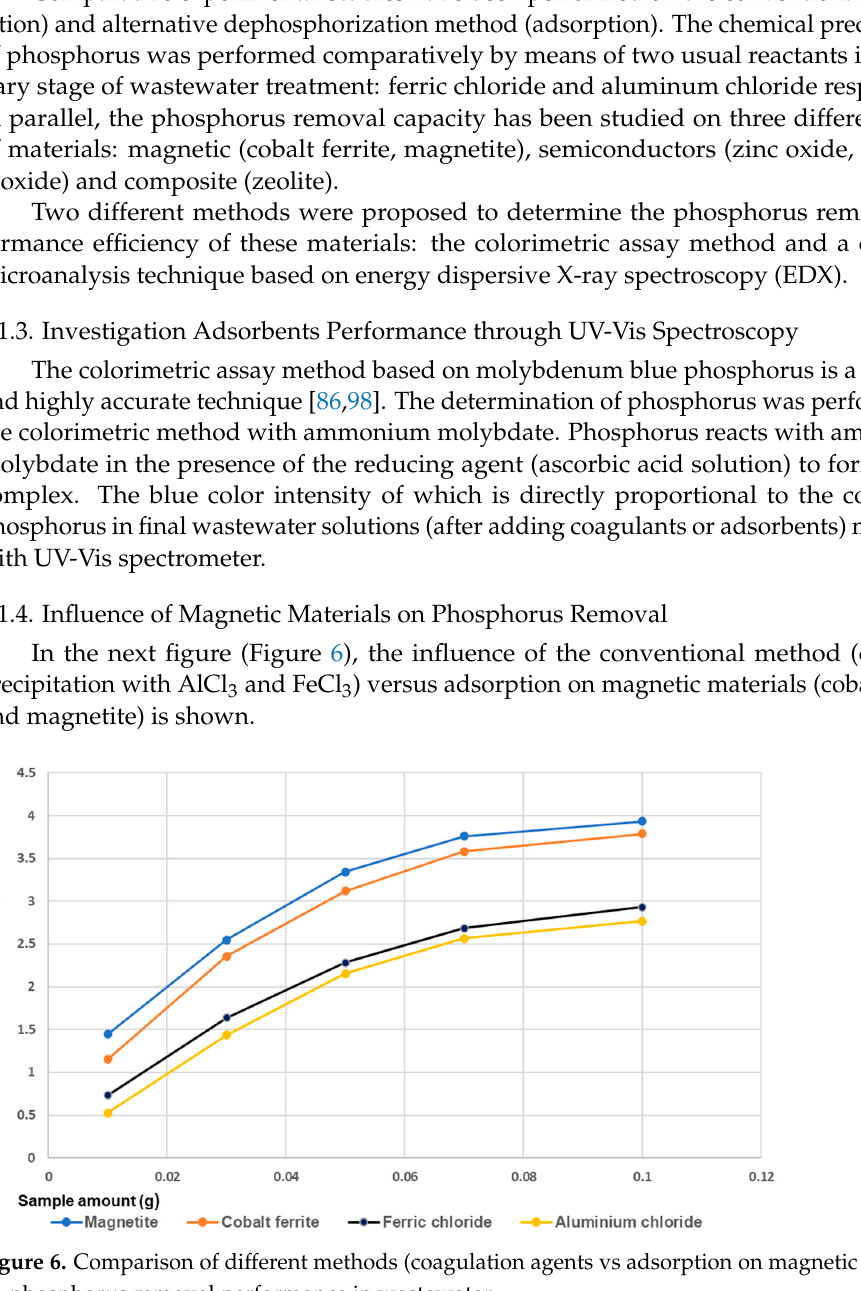
als) on phosphorus removal performance in